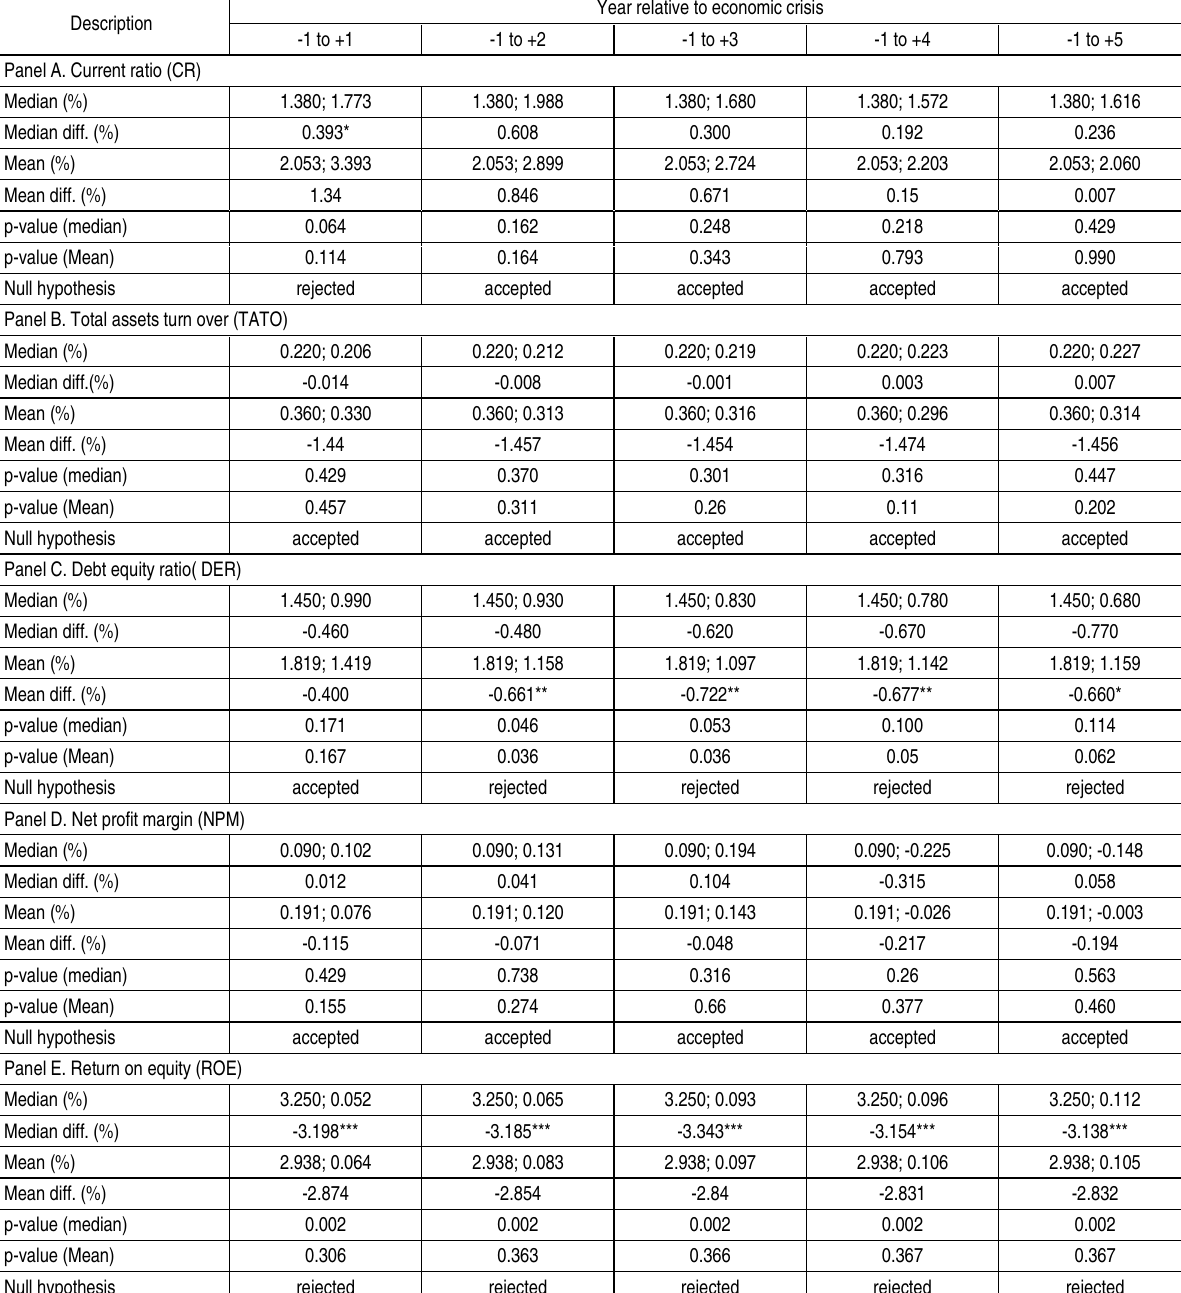
Table 3. Results of test of mean (median) difference of financial performance, before and after the crisis